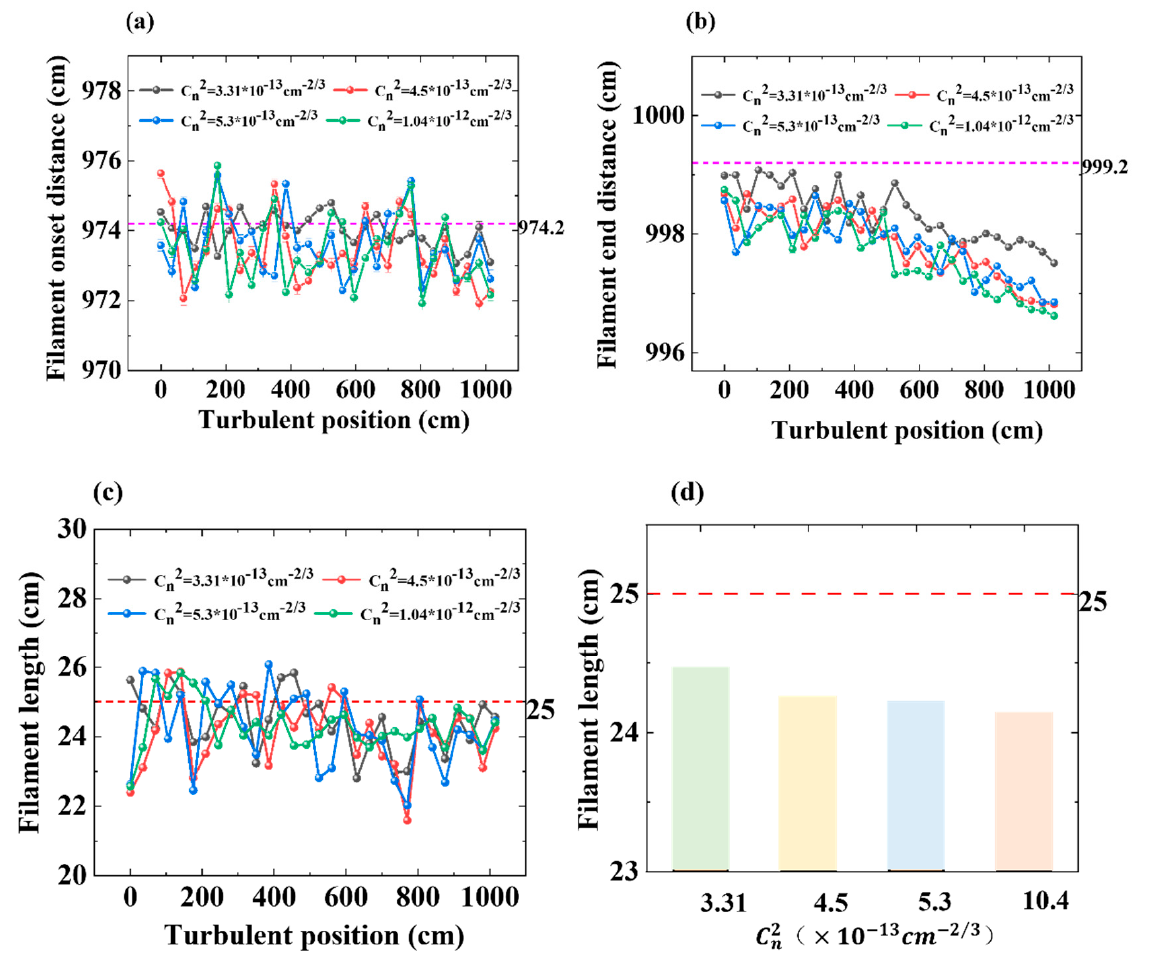
Figure 6. ( a ) The onset distance of the filament varied with the turbulence position under the four turbulence strengths; ( b ) the end distance of the filament varies with the turbulence position under the four turbulence strengths; ( c ) filament length varies with the turbulence position under the four turbulence strengths; ( d ) mean filament length varies with the turbulence position under the four turbulence strengths. The pink baseline (dotted line) shows the beginning and ending positions of the filaments in the absence of artificial turbulence and the red baseline (dotted) line shows the mean length of the filament without artificial turbulence.